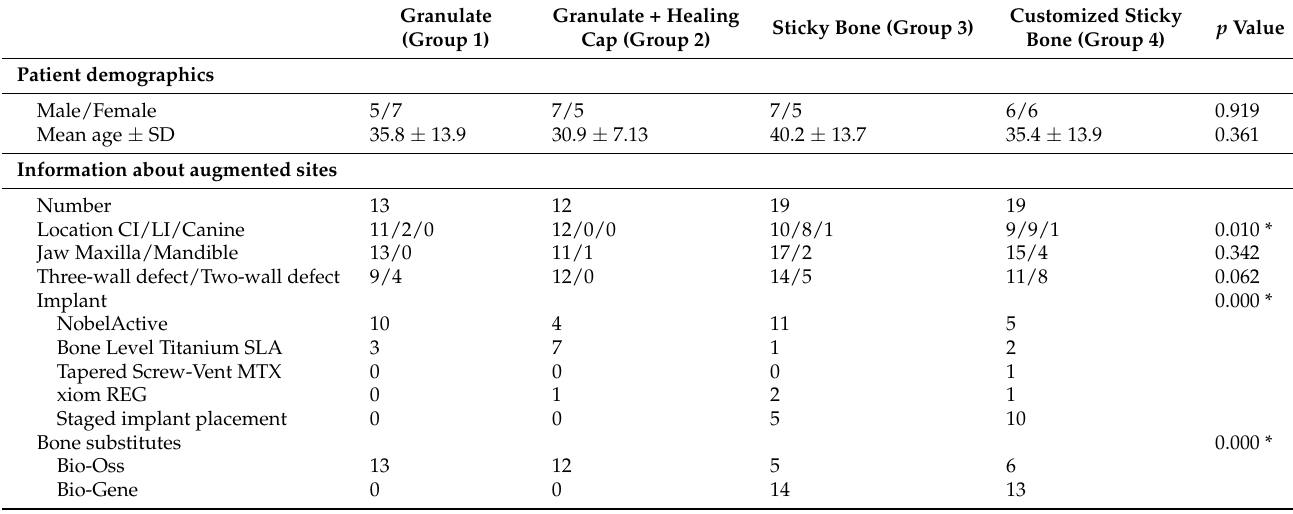
Table 1. Descriptive statistics for each